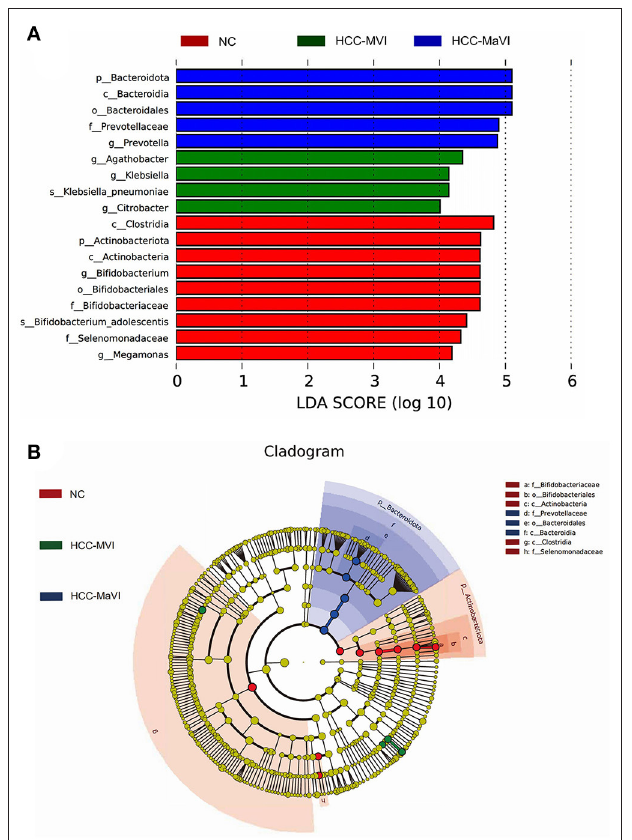
FIGURE 5 | LEfSe analysis of gut microbiota. (A) LefSe analysis showed significant bacterial differences among NC, HCC-MVI, and HCC-MaVI groups; (B) A cladogram of different taxonomic compositions among NC, HCC-MVI, and HCC-MaVI groups.